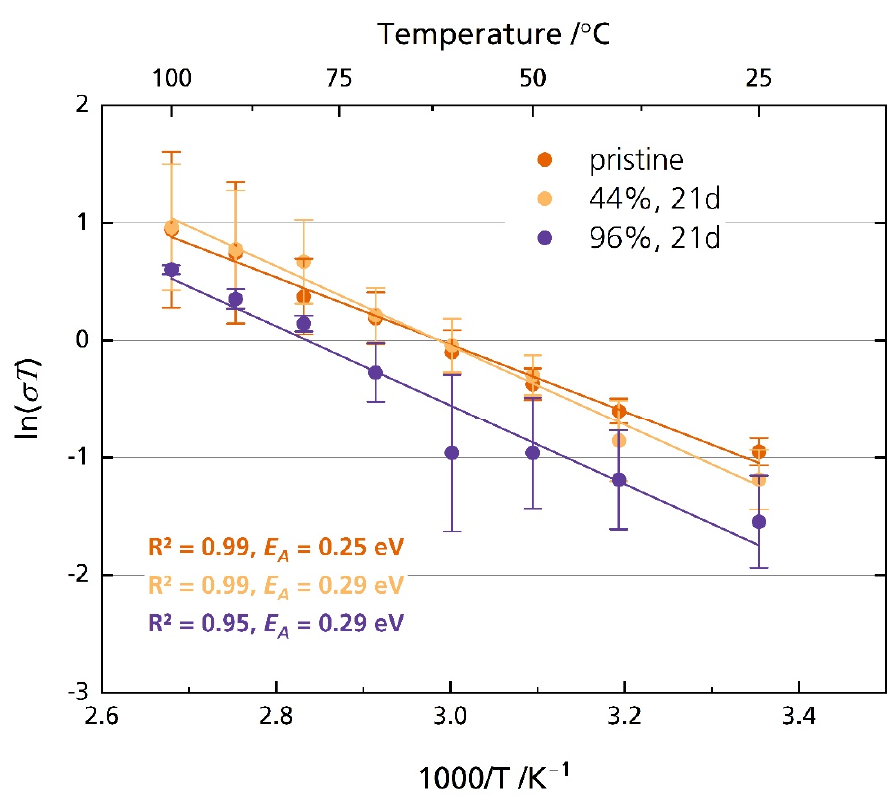
Figure 8. Arrhenius plot of the pristine disks and disks stored in 44% r.h. and 96% r.h. The disks were polished with corundum sandpaper after storage and before measurement. The error bars represent the standard deviations.